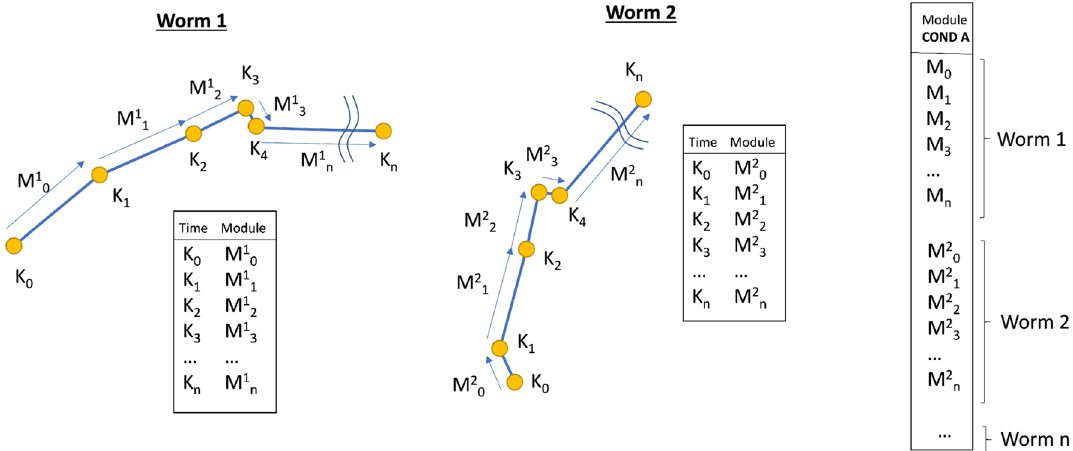
Figure 6. Module index. Every worm movement of every time instant is recorded (worm 1, worm 2 ... worm